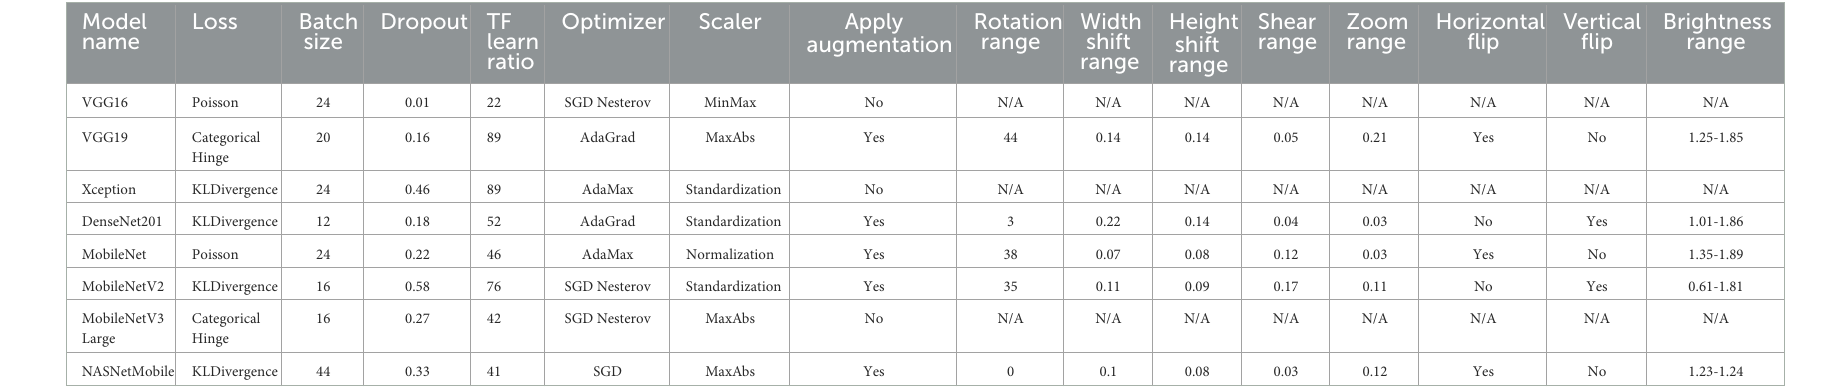
TABLE 9 The best solutions following the LOP for the Four-class dataset.